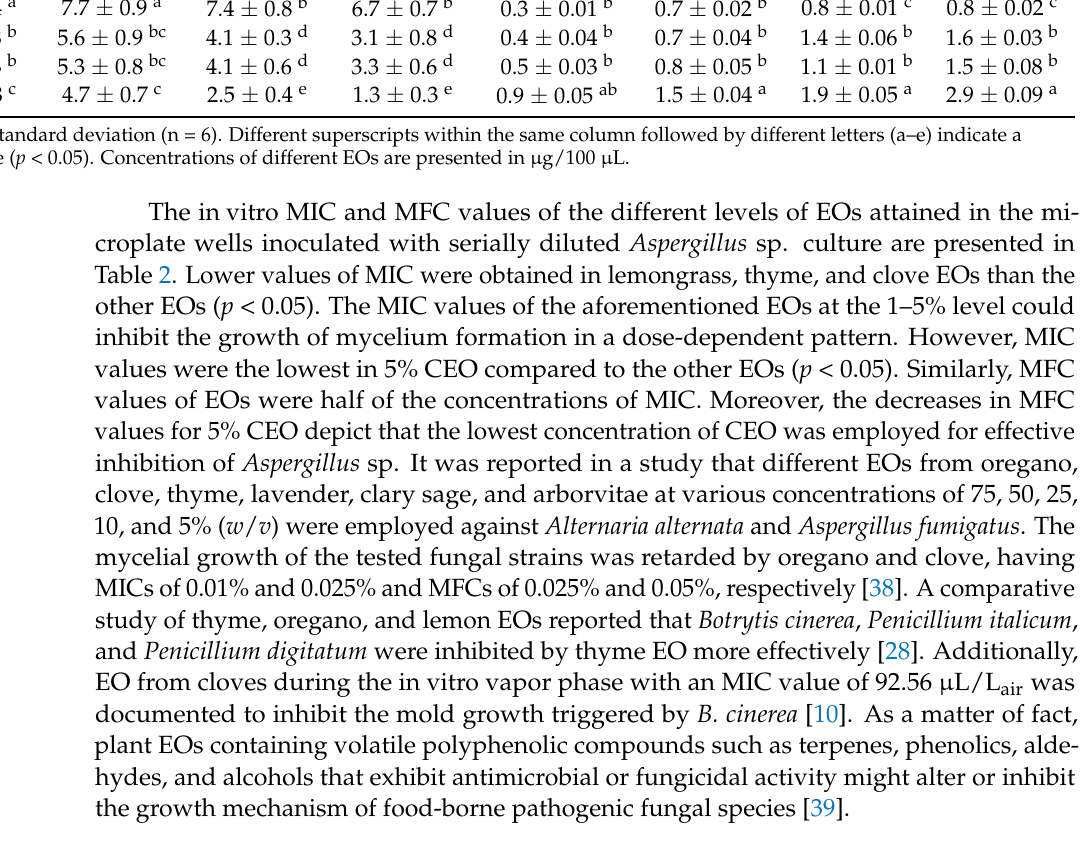
Table 1. Effect of different levels of EOs on radial growth and inhibition zone of Aspergillus sp.